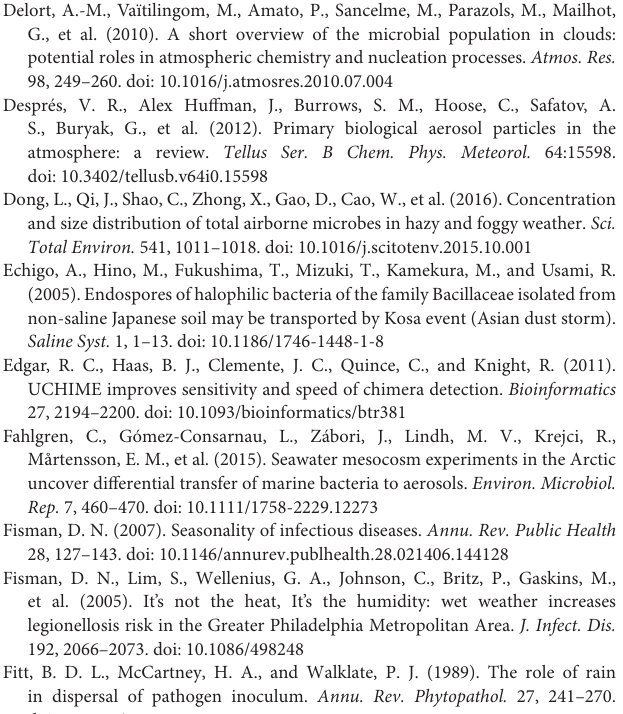
“terrestrial.” The estimated route of the air mass before each precipitation event is indicated in the right column. Supplementary Figure S5 | Estimated ordinary habitats of microbes in aerosol and cloud water samples. Estimated ordinary habitats demonstrating < 5% abundance were summarized as “Others.” Supplementary Table S1 | Amplicon-sequencing data of aerosol and cloud water